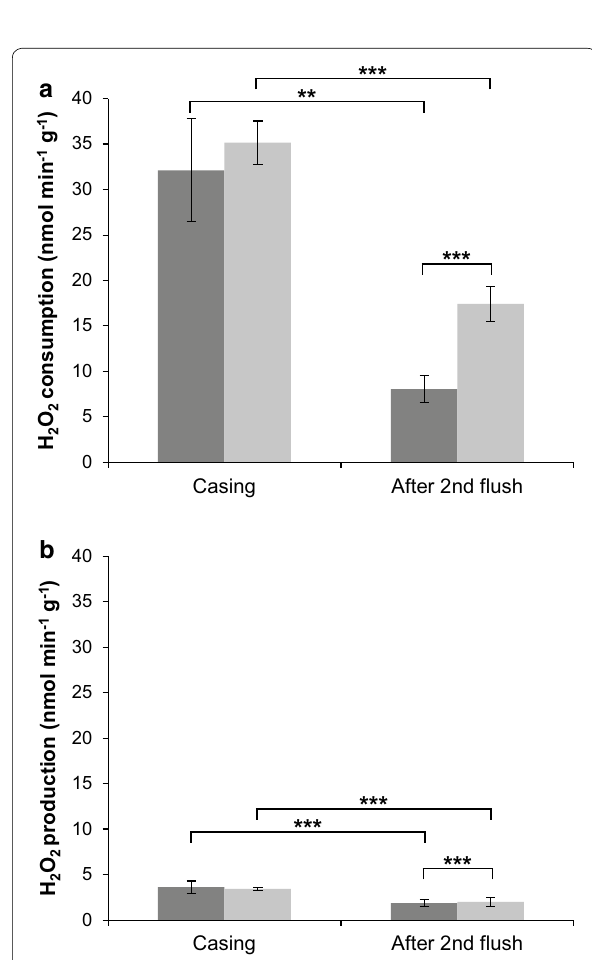
Fig. 5 H 2 O 2 consumption and production in compost extract from a semi-commercial cultivation of A15 ( dark shading ) and MnP1-1 ( light shading ). Statistical difference between the time points and between A15 and MnP1-1 are indicated. Error bars represent standard